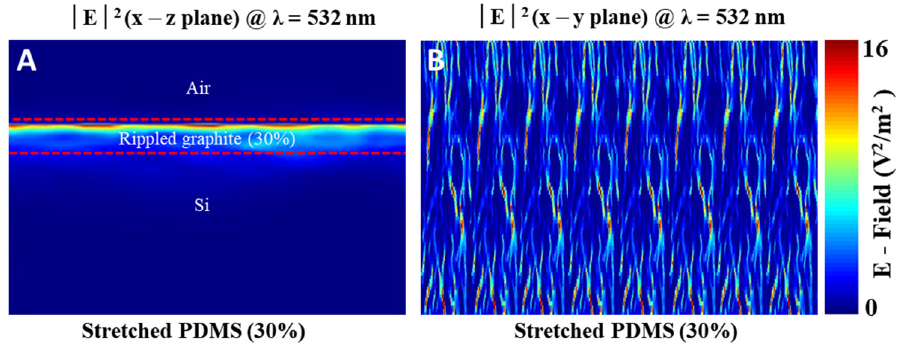
Figure 6. FDTD-simulated electric field intensity distribution of the stretched PDMS/rippled graphite/Si (30%) at 532 nm laser illumination. ( A ) intensity profile at the cross-section through x − z plane, ( B ) intensity profile at the cross-section through x − y